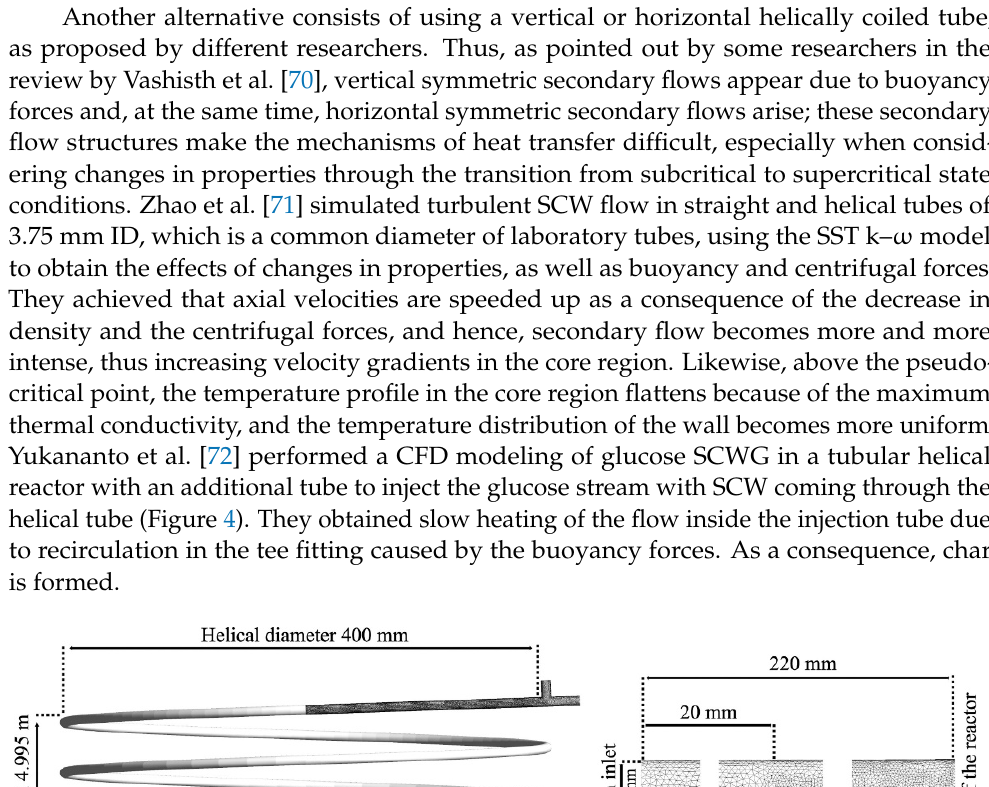
Figure 4. Scheme of the helical reactor ( A ) and the injector tube ( B ) [72]. Reprint with permission from ref. [72]. Copyright 2018 Elsevier.